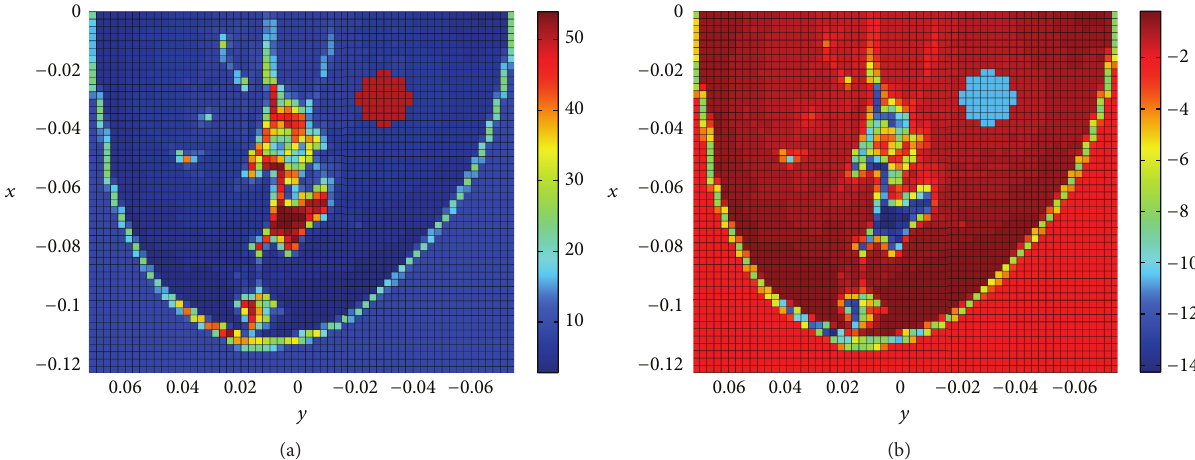
Figure 14: The permittivity in a sagittal slice at 𝑧 = 0 through the discretized realistic breast phantom for the synthetic data generation without added noise. The cell size is 2.5 mm and a 2 cm diameter tumor has been added. Real part (a) and imaginary part (b). Distances are in m.